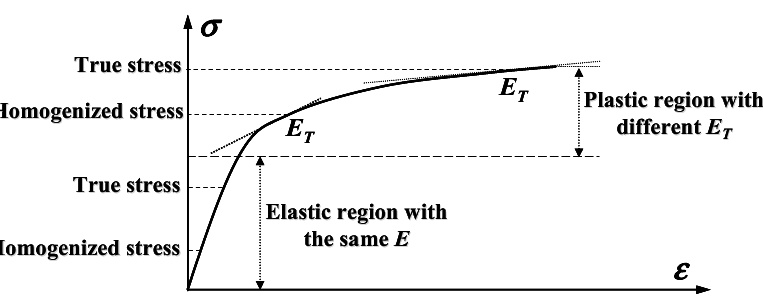
Figure 1. Schematic composite properties at different scales of stresses.